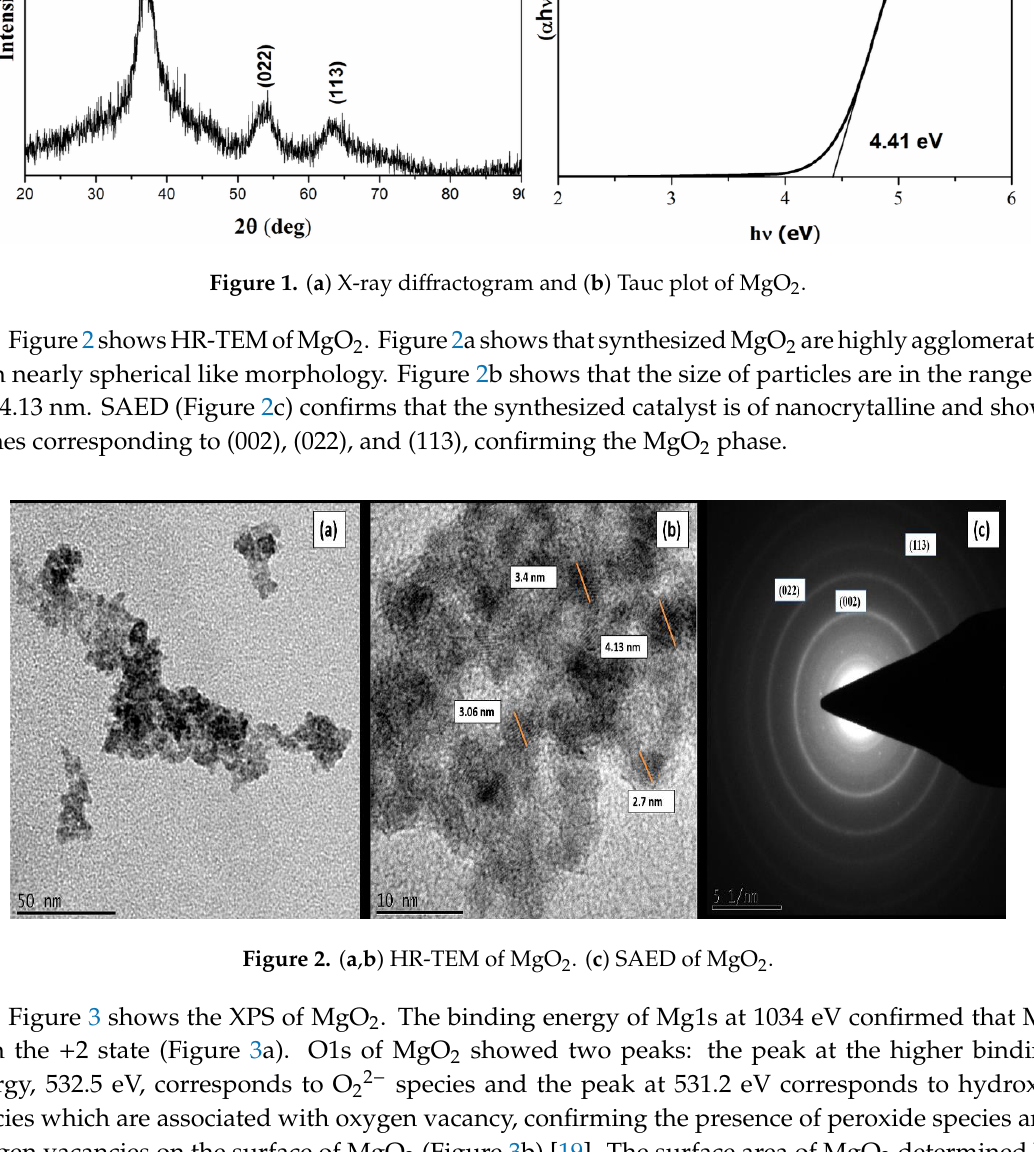
Figure 1. ( a ) X-ray diffractogram and ( b ) Tauc plot of MgO 2 .